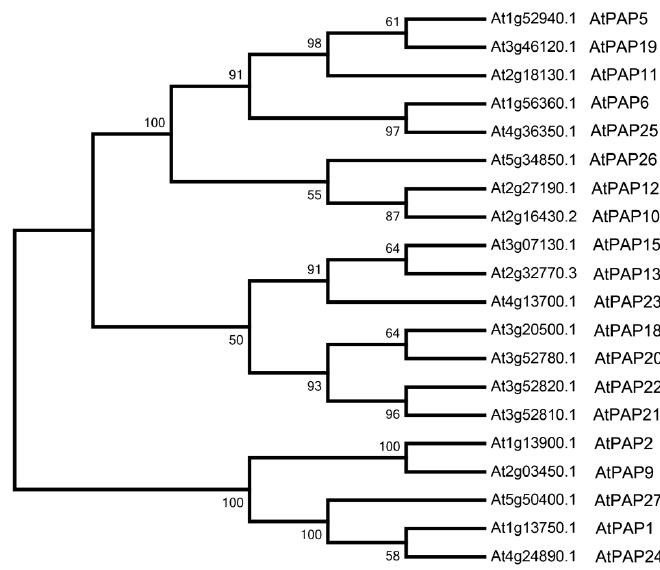
Figure 1. Phylogenetic analysis of AtPAP2 and its homologs in Arabidopsis . A phylogenetic tree of the protein sequences of AtPAP2 and their homologs in Arabidopsis . Bootstrap values at the corresponding nodes are based on 1000 bootstrapping replicates.